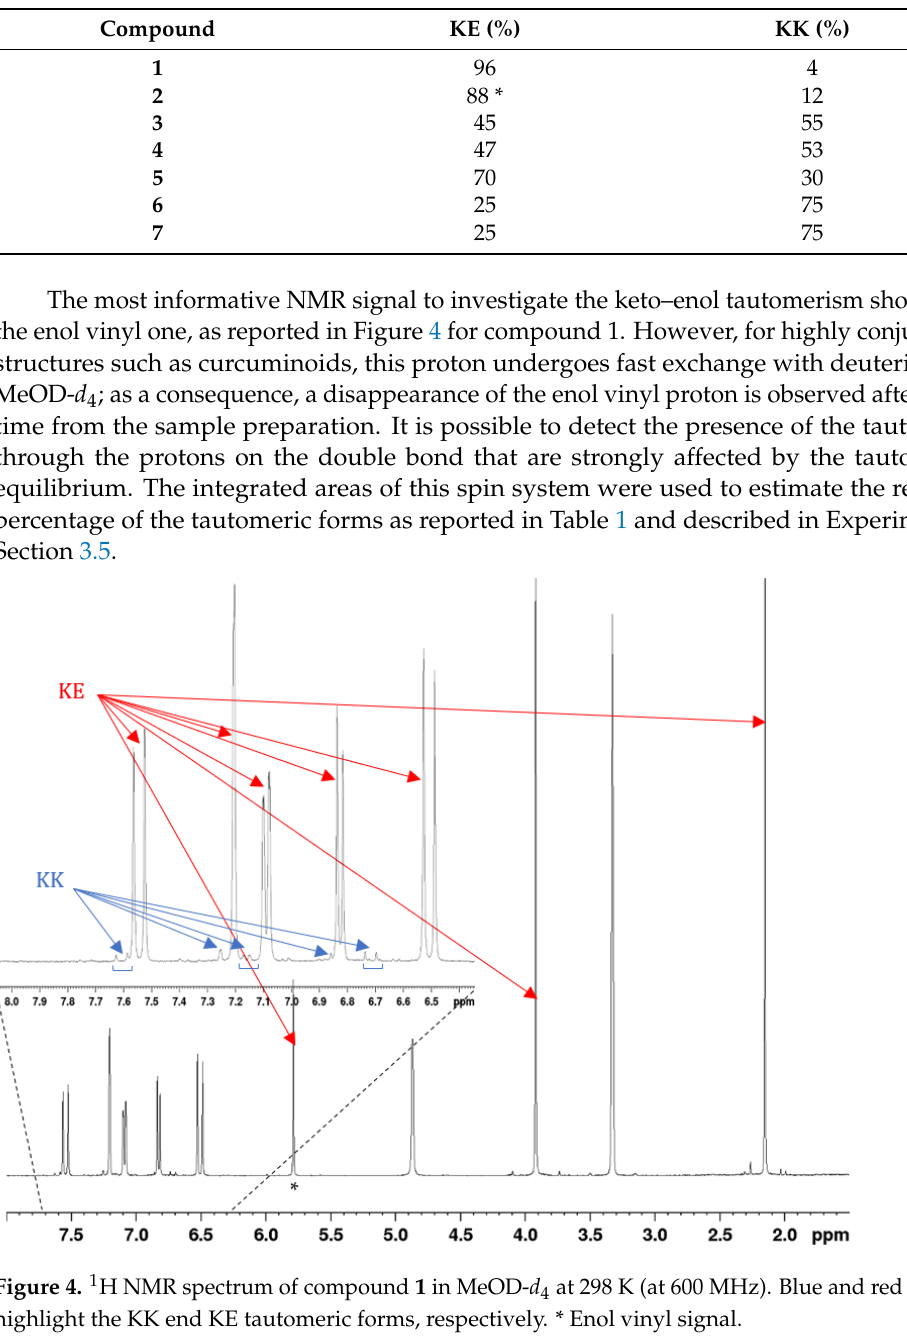
Table 1. Amount (molar percentage, %) of the keto–enol (KE) and diketo (KK) forms estimated based on the 1 H NMR data acquired in MeOD- d 4 at 298 K as reported in Experimental Section 3.5. * Percentage of KE includes the KE form of the Z isomer (6%).